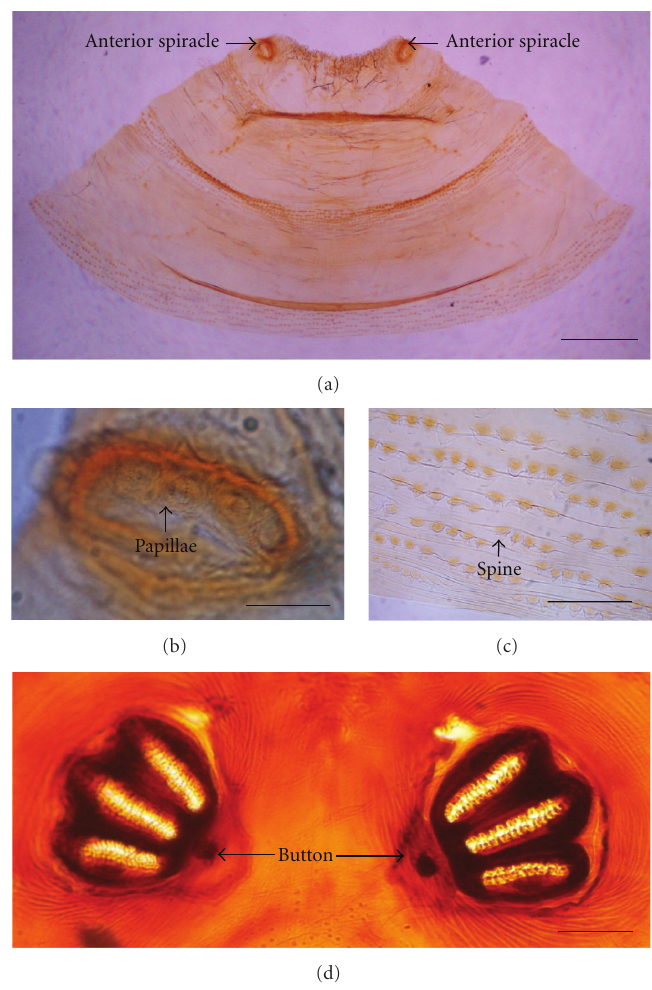
Figure 4: Puparium of Hemipyrellia ligurriens after treating with 10% KOH. (a) Anterior plate with trapezoid shape. (b) Anterior spiracle with 6 papillae. (c) Spine pattern at the 3rd segment showing single point tip. (d) Posterior spiracles. Bars = 100 µ m for all figures.